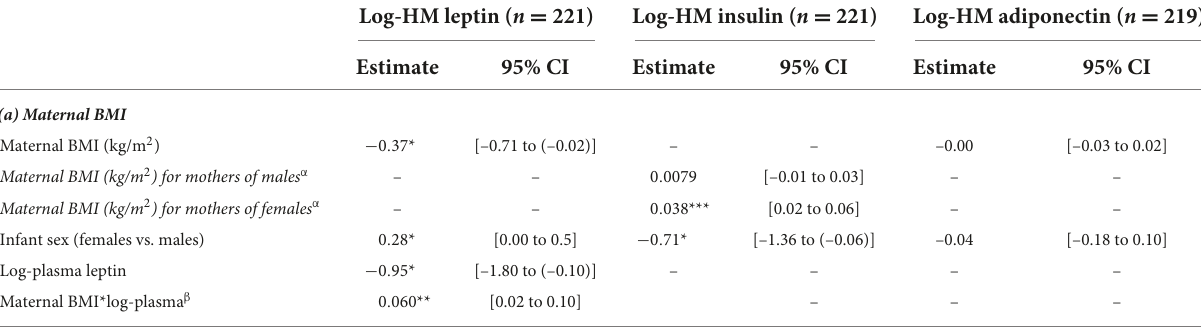
TABLE 3 Model estimates of the initial testing of the total effect (c 1 ) of maternal BMI on human milk leptin, insulin and adiponectin.